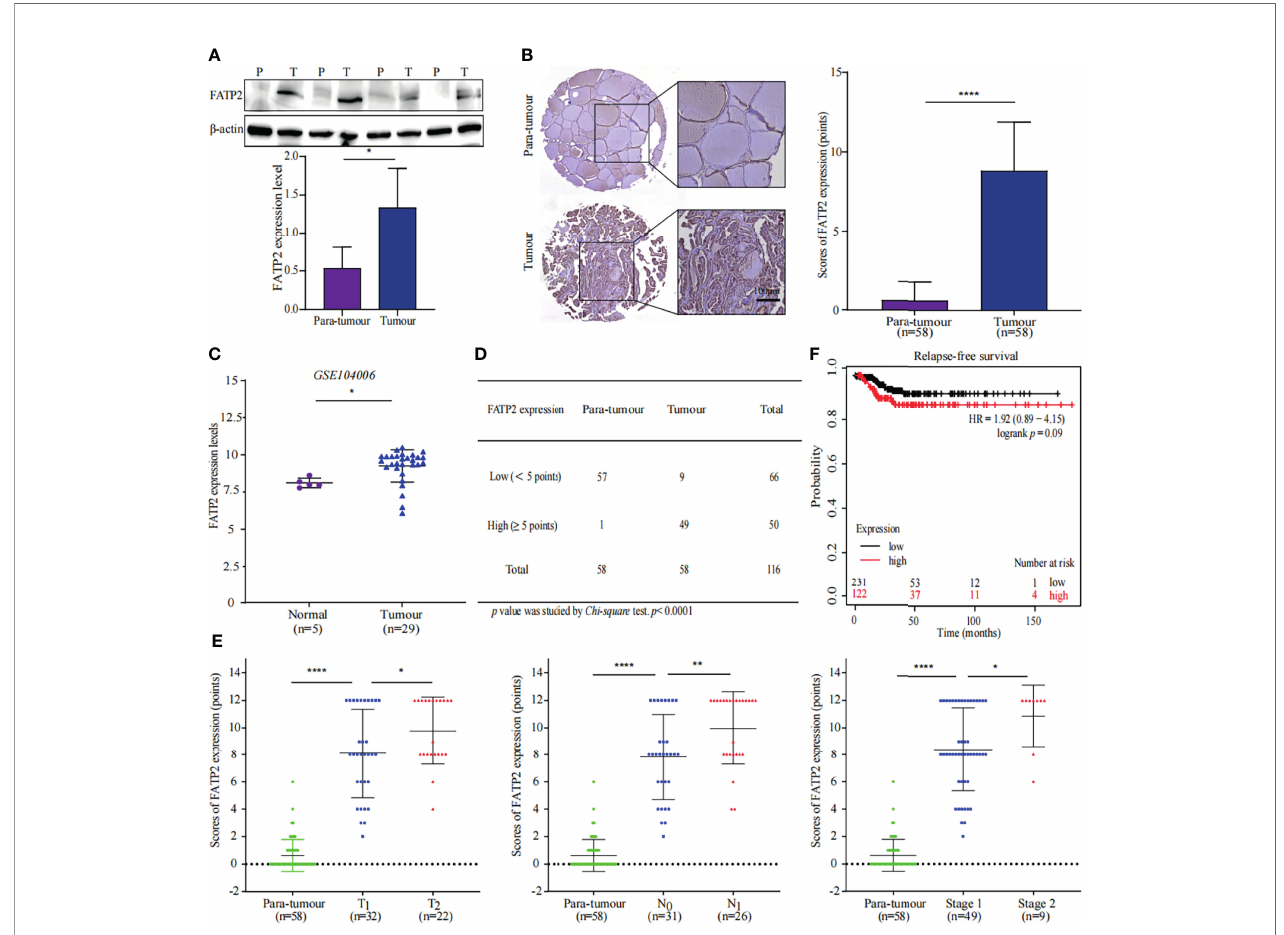
FIGURE 5 | Thyroid carcinoma is promoted by FATP2 overexpression. (A) FATP2 expression in the tissue samples was measured using western blotting (WB). Representative WB diagrams of FATP2 are shown in the top panel. Quanti fi cation data are shown in the lower panel, * p < 0.05. Error bar indicates s.d. , two-tailed unpaired t -test. P indicates para-tumour, T indicates tumour. (B) FATP2 expression and localization in tissue microarray. Representative images of immunohistochemical staining for FATP2 (brown) with Mayer ’ s haematoxylin counterstain are shown in the left panel. Scale bar 100µm. Statistical data of FATP2 protein levels in 58 paired thyroid samples are shown in the right panel. **** p < 0.0001. Error bar indicates s.d. , two-tailed unpaired t -test. (C) Data of FATP2 mRNA levels were obtained from publicly available dataset (GSE104006). * p < 0.05. The error bar indicates s.d. , student t -test. (D) The number of FATP2-positive tissue samples in the tissue microarray. The Chi-square test was used to analyse the signi fi cant difference, **** p < 0.0001. (E) Correlation between FATP2 expression and thyroid cancer progression. The graph in the left panel shows that FATP2 expression was positively correlated with the T stage of PTC. The graph in the middle panel shows that FATP2 expression was positively correlated with the N stage of PTC. The graph in the right panel shows that FATP2 expression was positively correlated with the TNM stage of PTC. **** p < 0.0001, ** p < 0.01, * p < 0.05. All error bars indicate s.d. , two-tailed unpaired t -test. (F) High FATP2 expression was associated with poor relapse-free survival. The online tool KM plot (http://kmplot.com/analysis/) was used to analyse thyroid carcinoma in pan-cancer